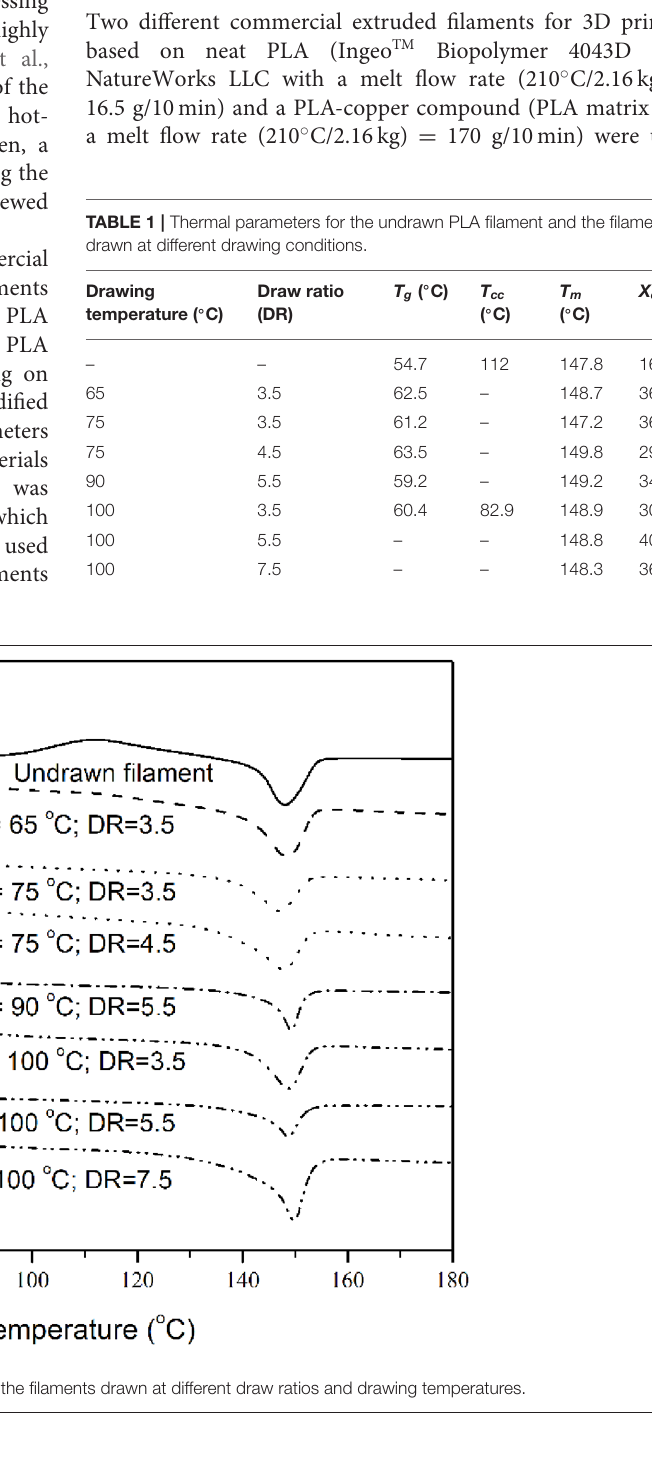
Frontiers in Materials |